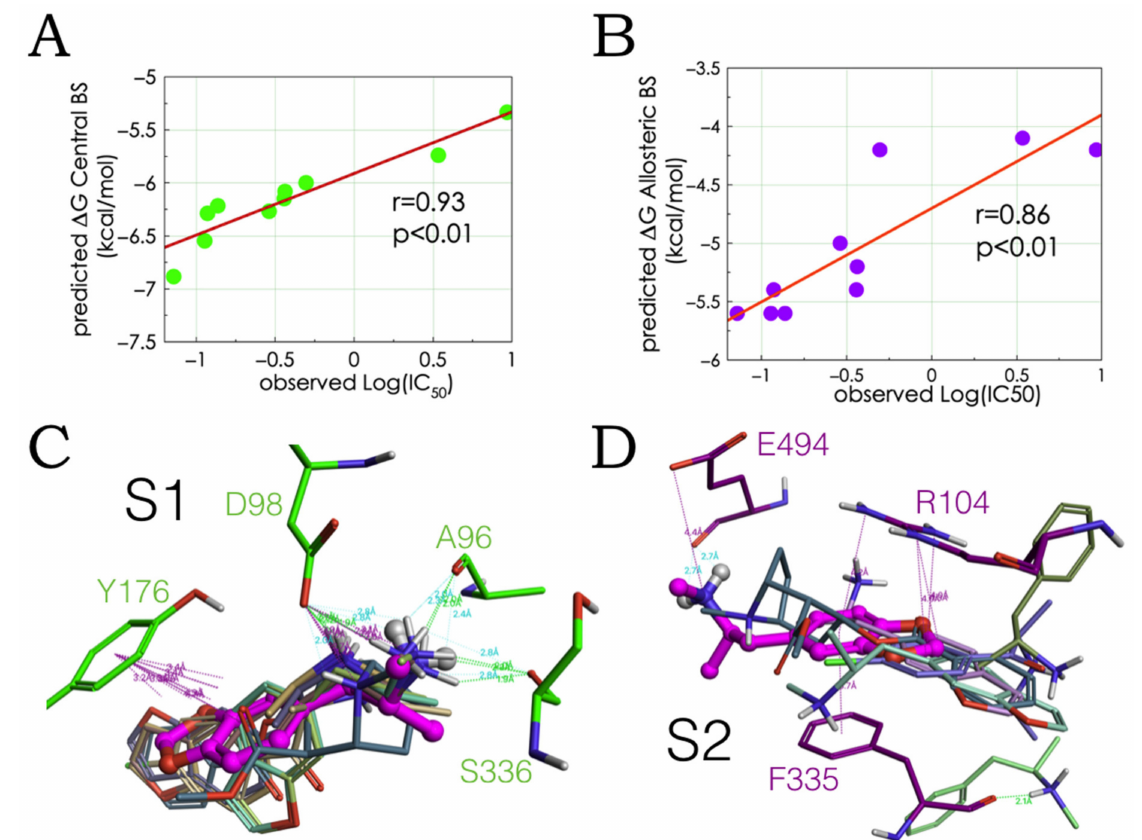
Figure 3. Correlation between experimental and computed data. The calculated Gibbs free energies of drugs in Figure 3, bound to S1 ( A ) or S2 ( B ) are plotted as a function of their [ 3 H]5-HT reuptake block activities. The linear regressions (y = x × a + b) are associated to Pearson correlation coefficients. Binding modes of these compounds to S1 ( C ) and to S2 ( D ) of the hSERT. Ionic and aromatic bonds (in purple) and H-bonds (in cyan = weak, green = strong) are associated to their distances. MDMA is in ball and stick representation in